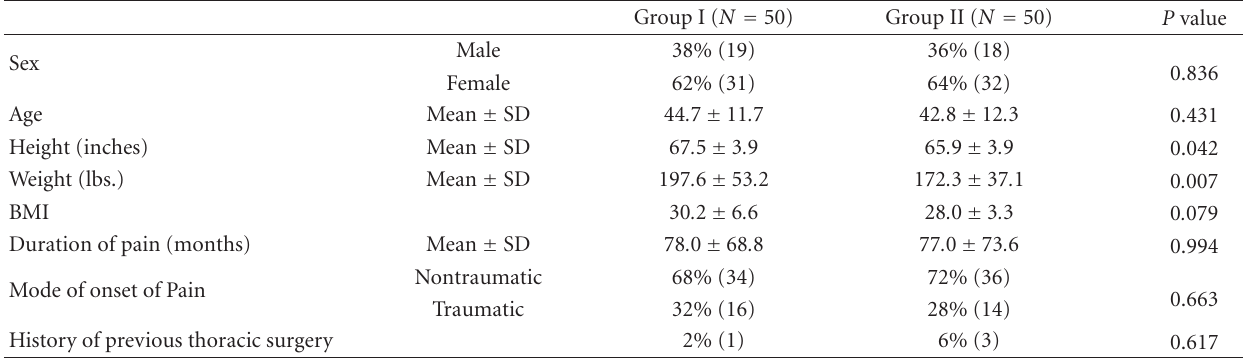
Figure 1: Schematic presentation of participant flow at 2-year followup. Table 1: Baseline demographic